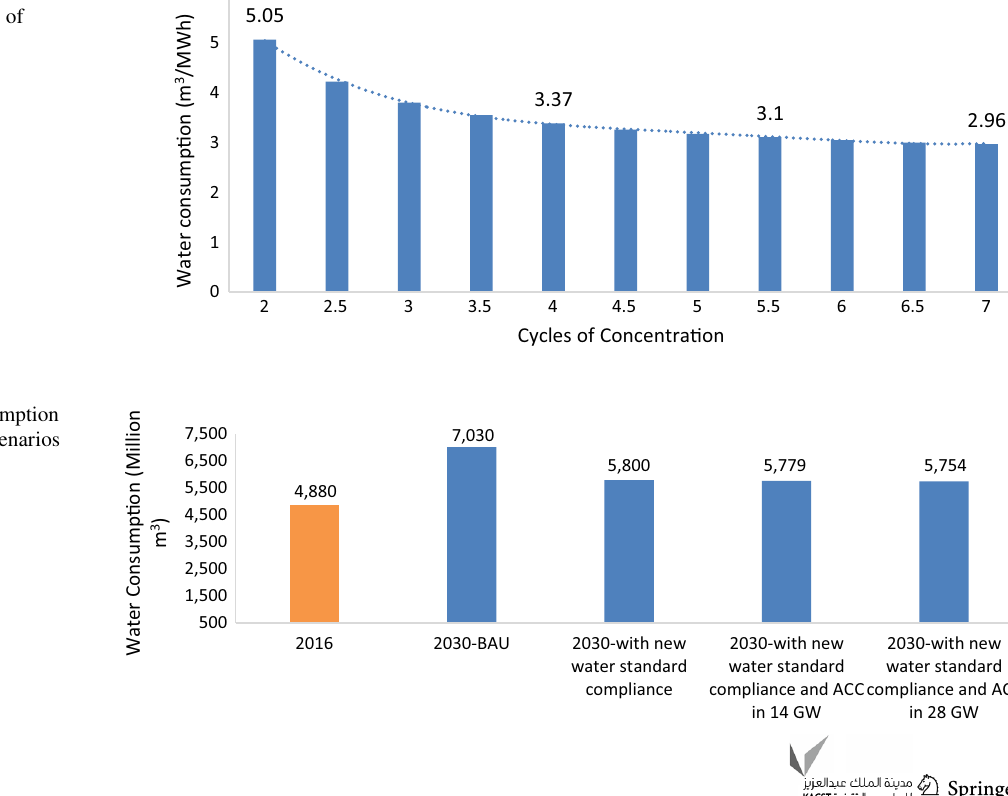
consumption with cycles of concentration